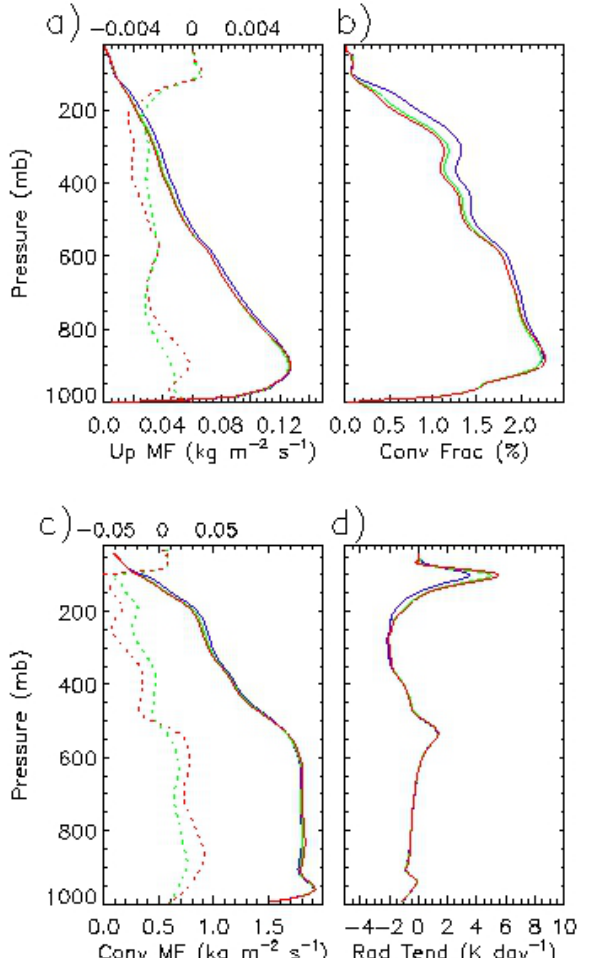
Fig. 14. As in Fig. 13, except for ensemble-average profiles of (a) updraft mass flux, (b) fraction of the domain containing convec- tive updrafts, (c) convective updraft mass flux averaged over cells containing convective updrafts, and d) temperature tendency due to radiative heating, for PRIS (blue), POLL (green), and SPOLL (red). Also shown in (a) and (c) are differences between POLL and PRIS (green dotted line) and SPOLL and PRIS (red dotted line), with val- ues shown on the axis at the top of the plots.